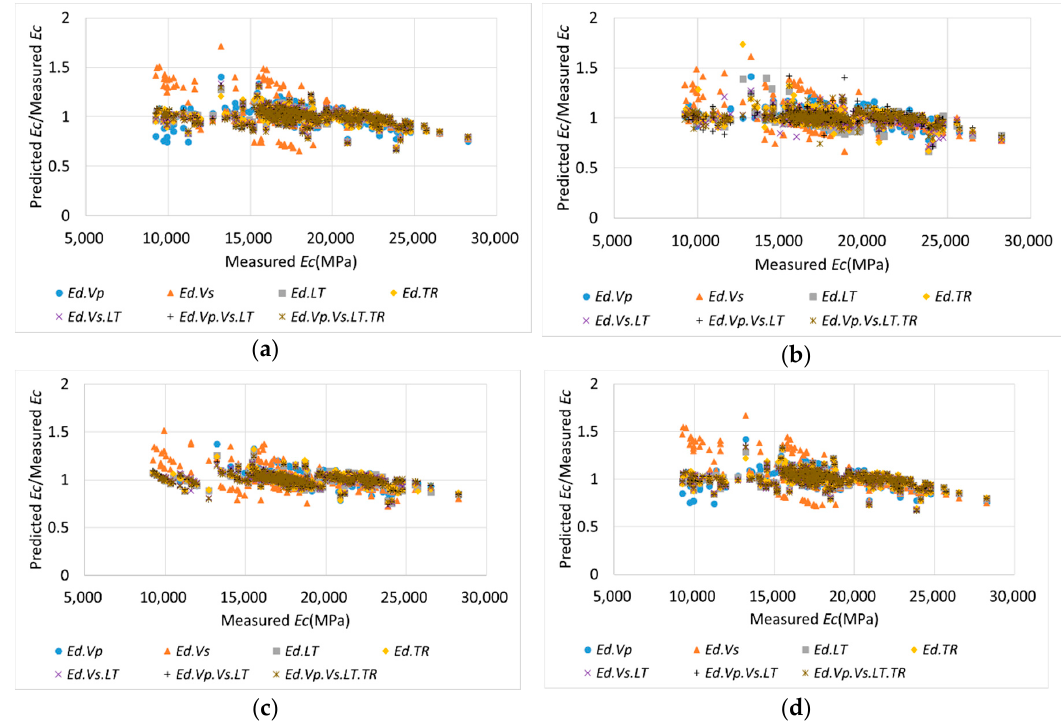
Figure 10. Relationship between measured Ec and the ratio of predicted Ec to measured Ec using ML methods: ( a ) SVM; ( b ) ANN; ( c ) Ensemble; ( d ) LR.